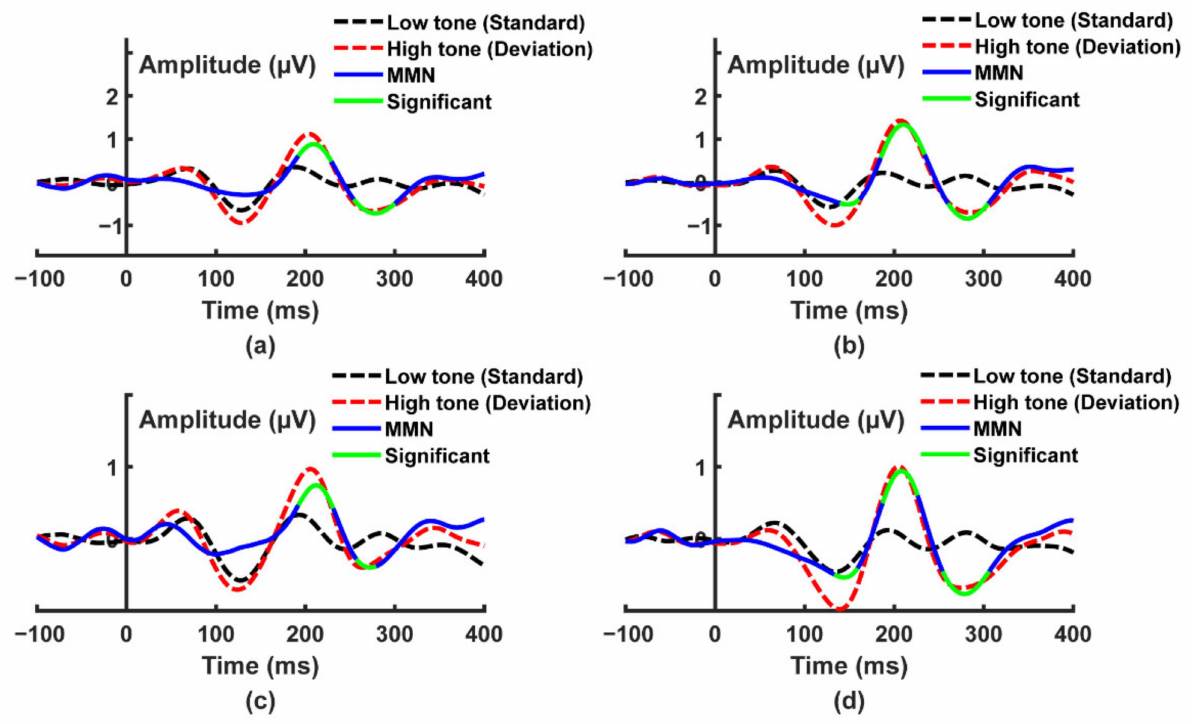
Figure 7. The averaged event related potential (ERP) curves of Mindeep with low tone and high tone stimulation. ( a ) Fp1; ( b ) Fp2; ( c ) F7; and ( d ) F8.